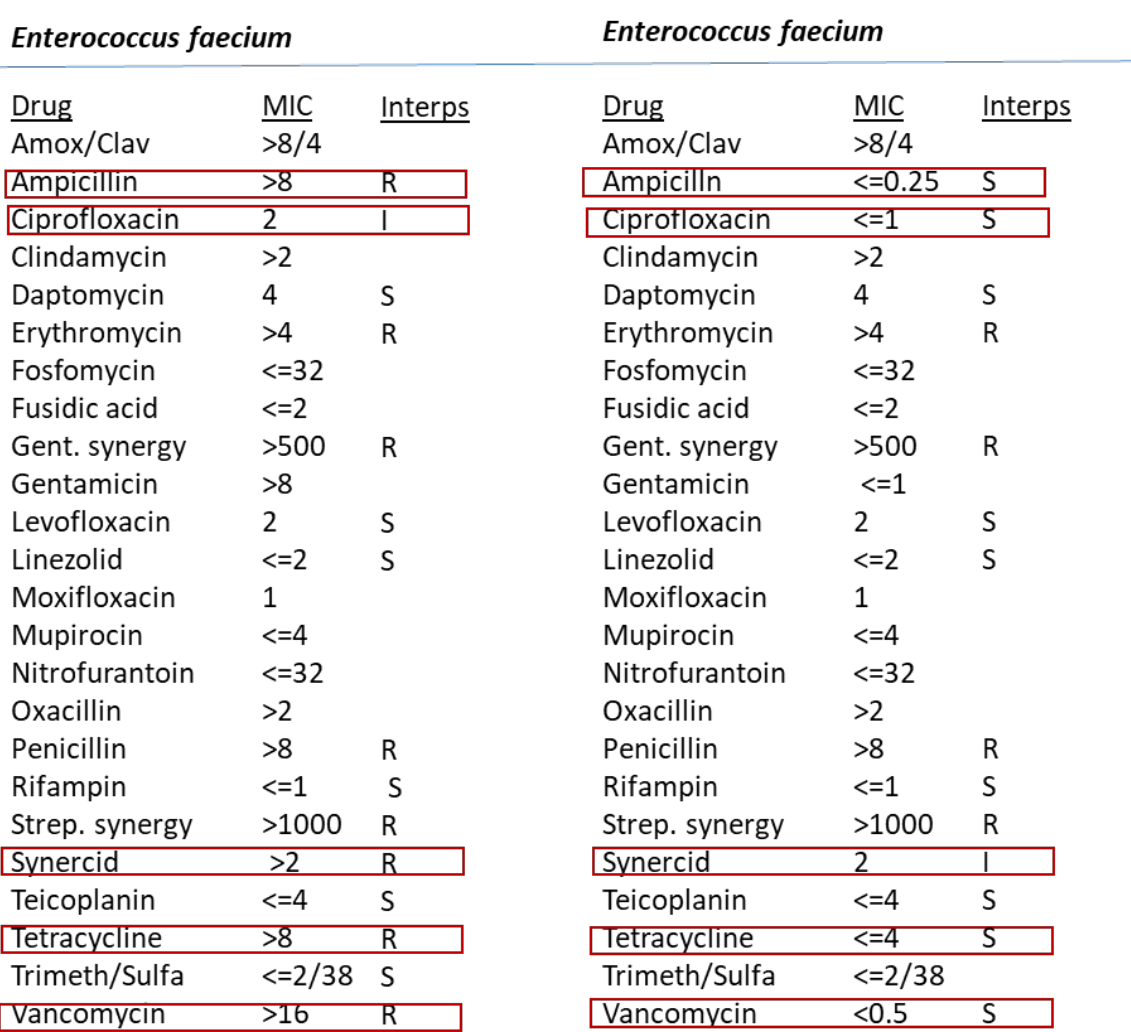
Figure 9. Demonstration of effect of bovine lactoferrin (bLF) on Vancomycin resistant Enterococcus faecium